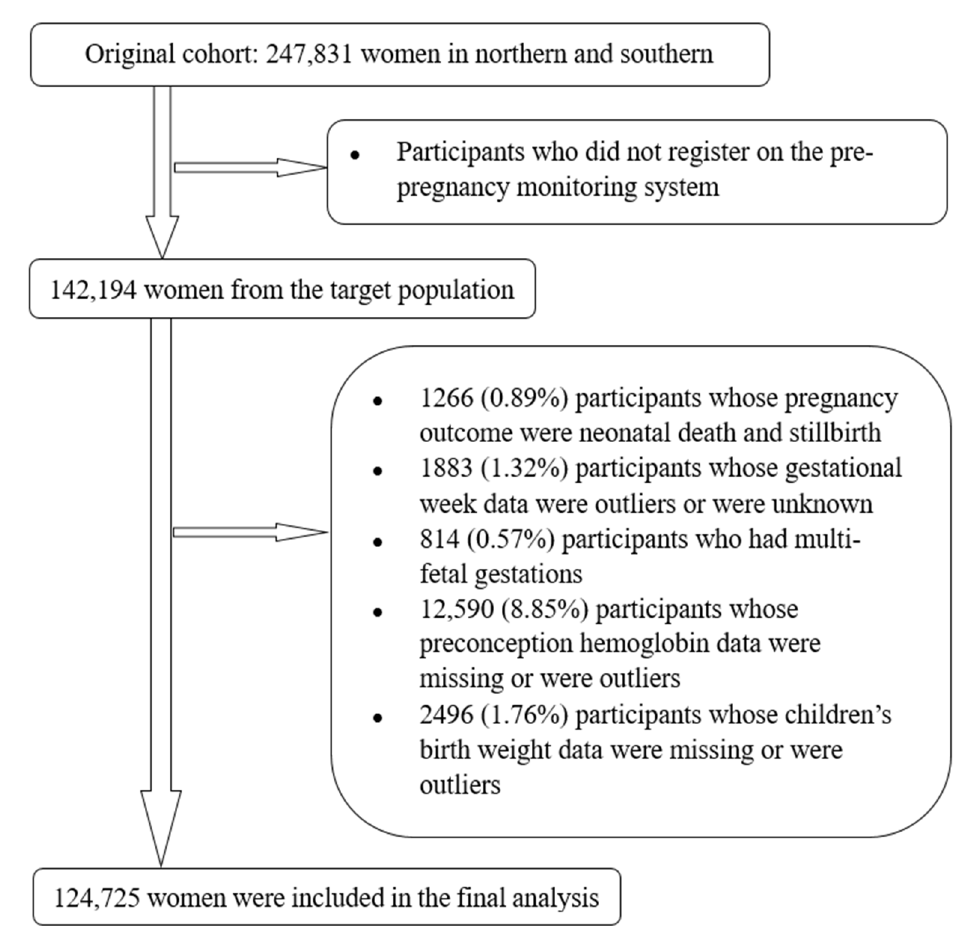
Figure 1. Flowchart of the participants.